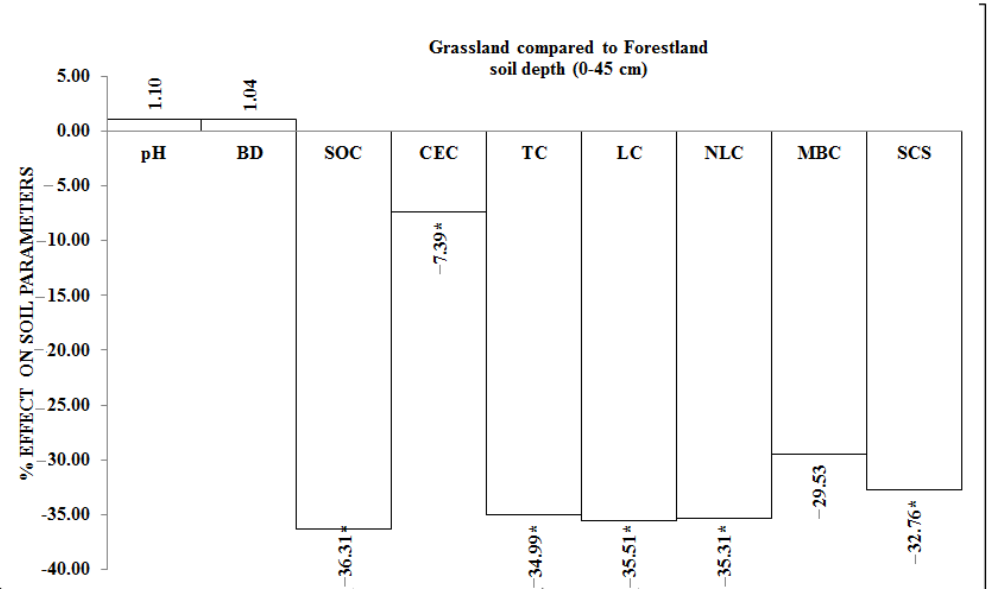
Figure 3. Percent mean effect of grassland compared to forestland in cumulative soil depth 0 – 45 cm on soil parameters in India (* indicates significant difference at p value < 0.05. Here, BD: bulk density, SOC: soil organic carbon, CEC: cation exchange capacity, TC: total carbon, LC: labile carbon, NLC: non-labile carbon, MBC: microbial biomass carbon and SCS: soil carbon stocks).